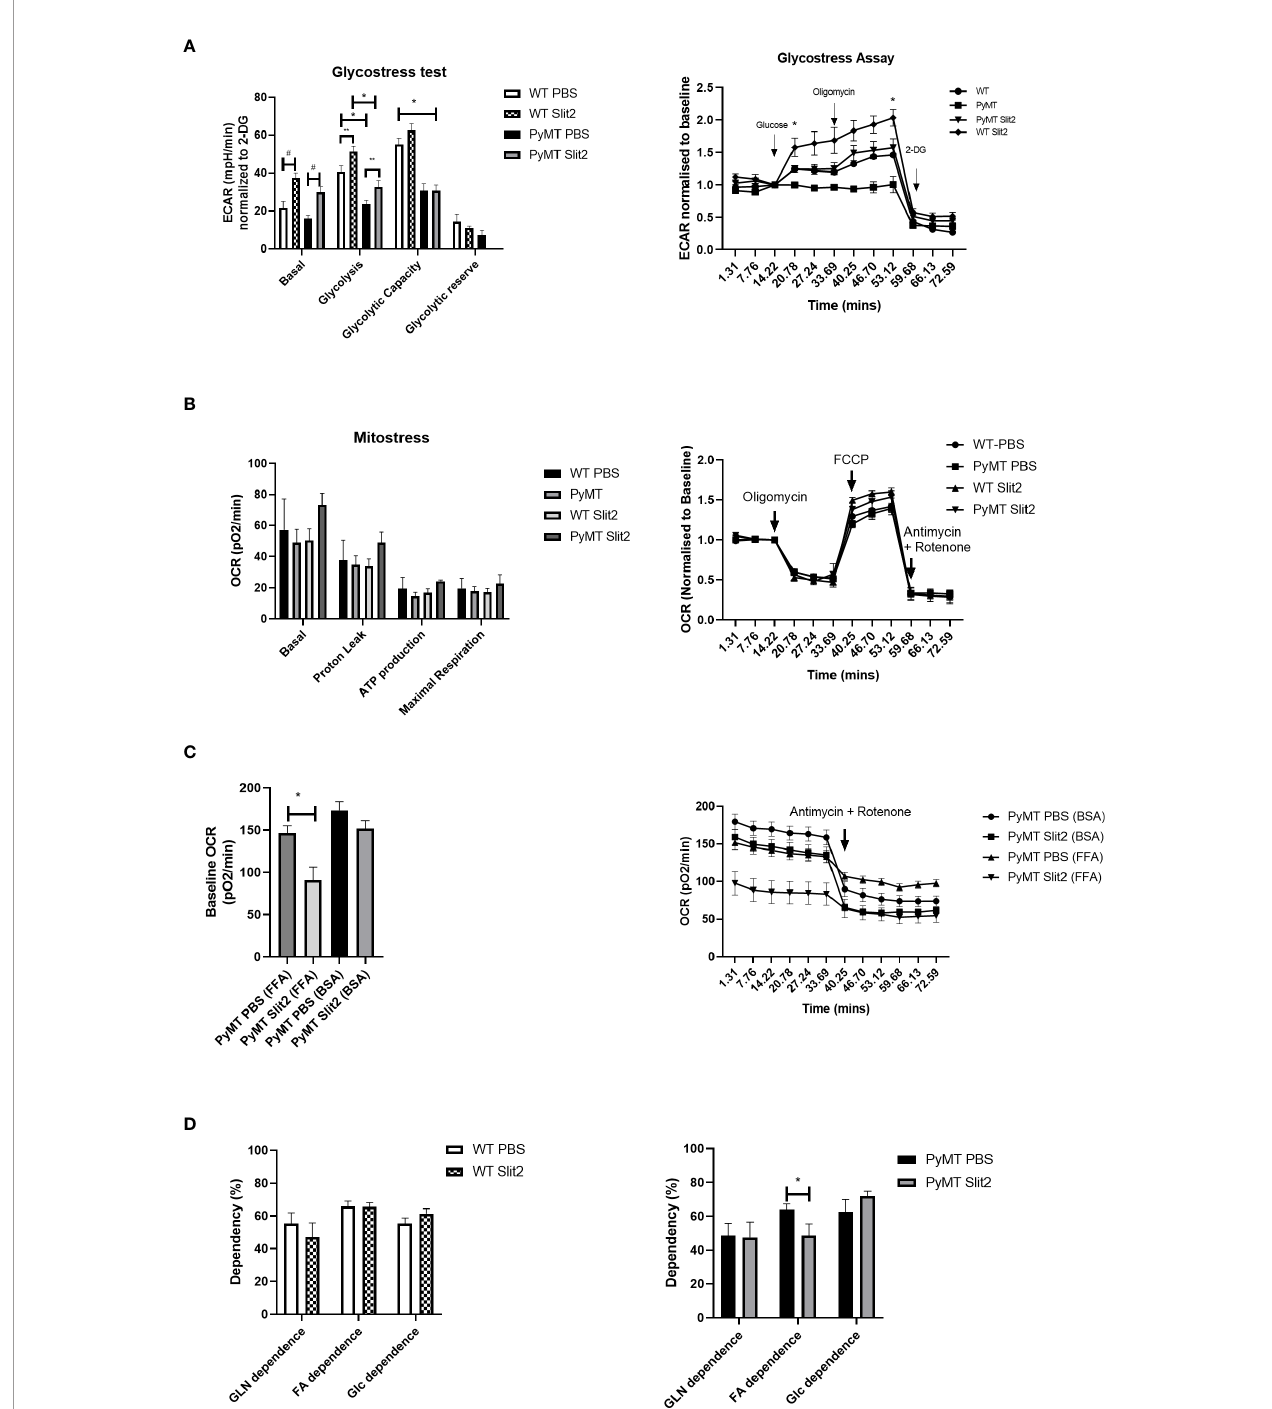
FIGURE 2 | (A) Histogram of Glyco Stress test performed in BMDMs from PBS- and Slit2-treated WT and PyMT mice. The fi gure on the right represents kinetics of the assay, normalized to a steady reading at baseline. (B) Mito Stress test performed in BMDMs from PBS- and Slit2-treated WT and PyMT mice. The fi gure on the right represents kinetics of the assay, normalized to a steady reading at baseline. (C) Baseline oxygen consumption rate in response to pretreatment with BSA-conjugated free fatty acids. (D) Substrate dependence derived using the Mito Fuel Flex assay. The graph on the left represents the difference in substrate dependence between BMDMs from PBS- and Slit2-treated WT mice, while the graph on the right represents the difference in substrate dependence between BMDMs from PBS- and Slit2-treated PyMT mice. The images represent n=3 – 5/group. *p < 0.05, WT vs. PyMT, # p < 0.05 PBS- vs. Slit2-treated groups based on one-way ANOVA, **p < 0.05 PBS- vs. Slit2-treated groups based on unpaired